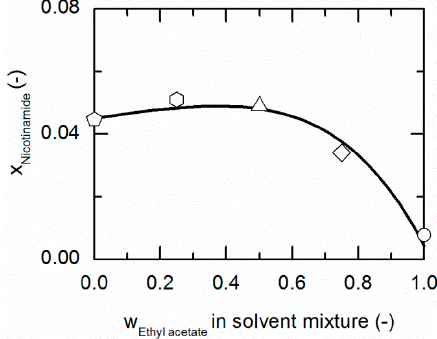
Figure 3. Solubility of nicotinamide (NA) in ethanol/ethyl acetate mixtures at 298.15 K. The line correspond to the PC-SAFT correlation; symbols represent the experimental data points for NA in ethanol (pentagon), in the ethanol/ethyl acetate (solute-free) mixtures 0.75/0.25 w / w (hexagon), 0.5/0.5 w / w (up-pointing triangle), 0.25/0.75 w / w (diamond) and in ethyl acetate (circle).